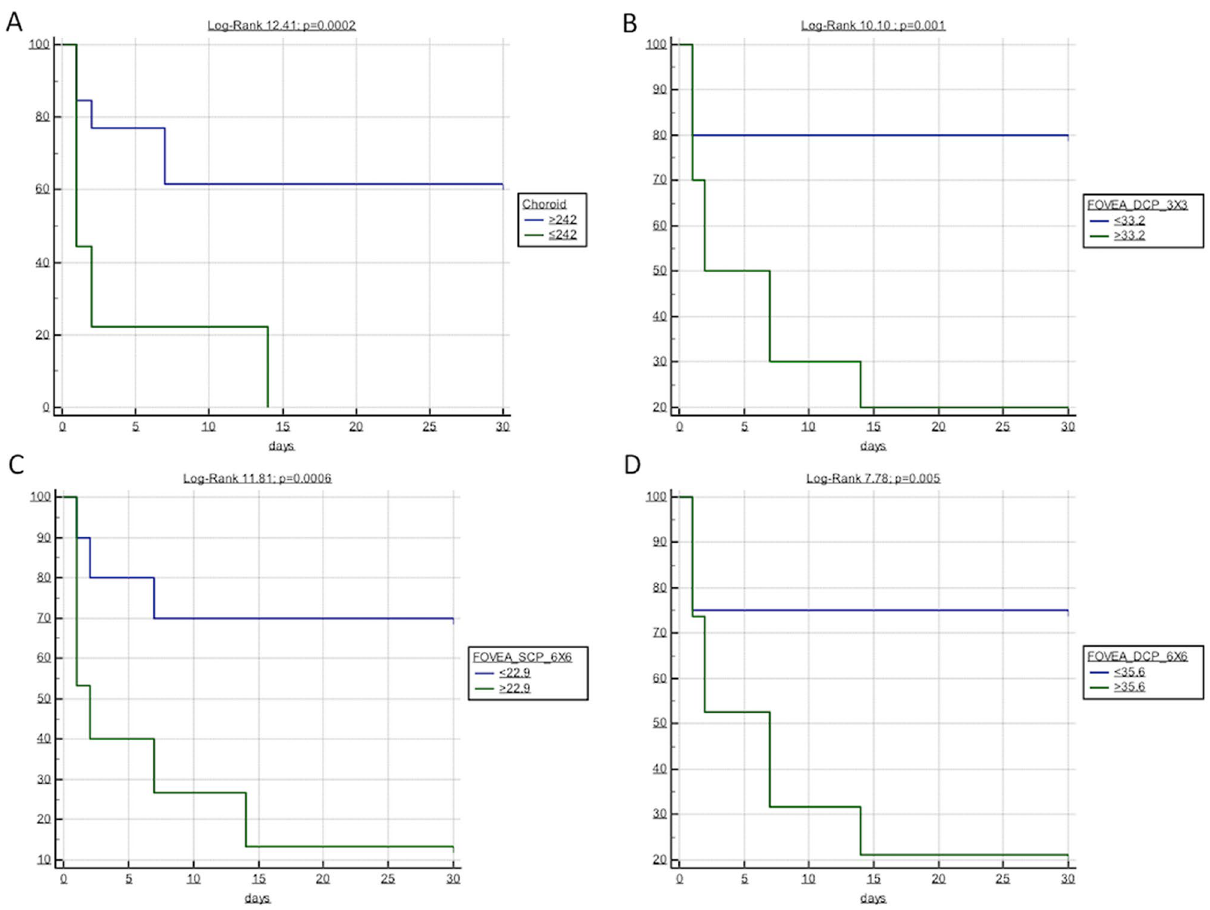
Figure 5. Kaplan–Meier survival curves of intradialytic hypertension-free patients according to the optimal ROC-derived cut-off for ( A ) Choroid, ( B ) 3 × 3 foveal DCP, ( C ) 6 × 6 foveal SCP and ( D ) 6 × 6 foveal